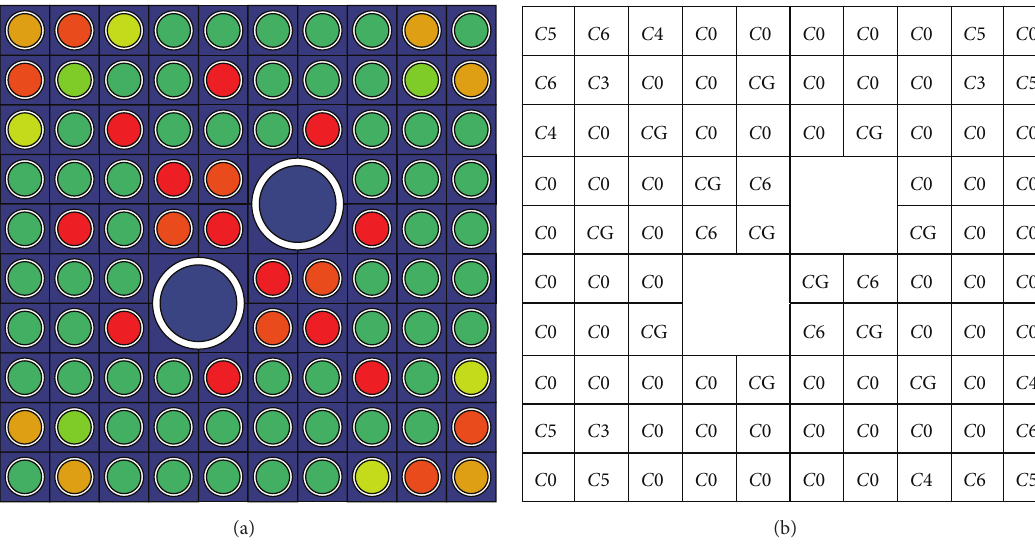
Figure 2: Arrangement of fuel rods for blue assembly (half enrichment). (a) DRAGON code output. (b) Bar type (see Table 2). Notice that initially there are no fuel bars with Pu.